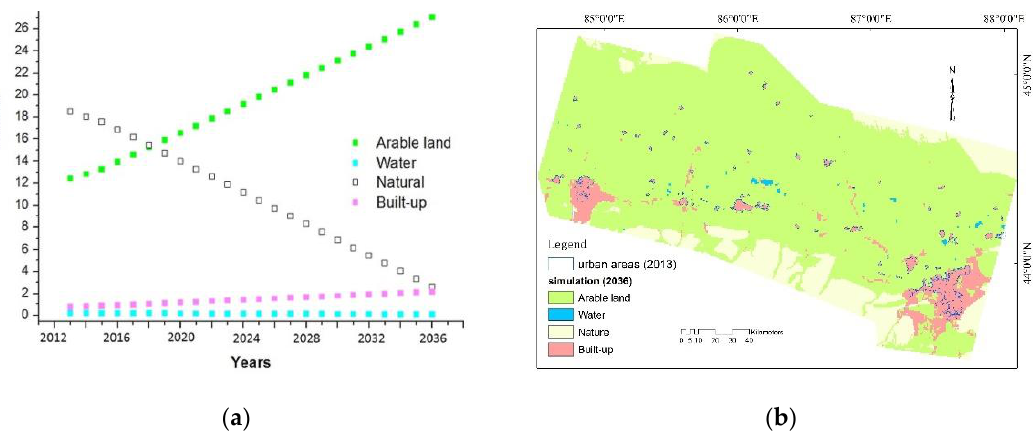
Figure 7. ( a ) Land use demand from 2013 to 2036. ( b ) Simulation results of rapid urban expansion supported by policies, for the year 2036.